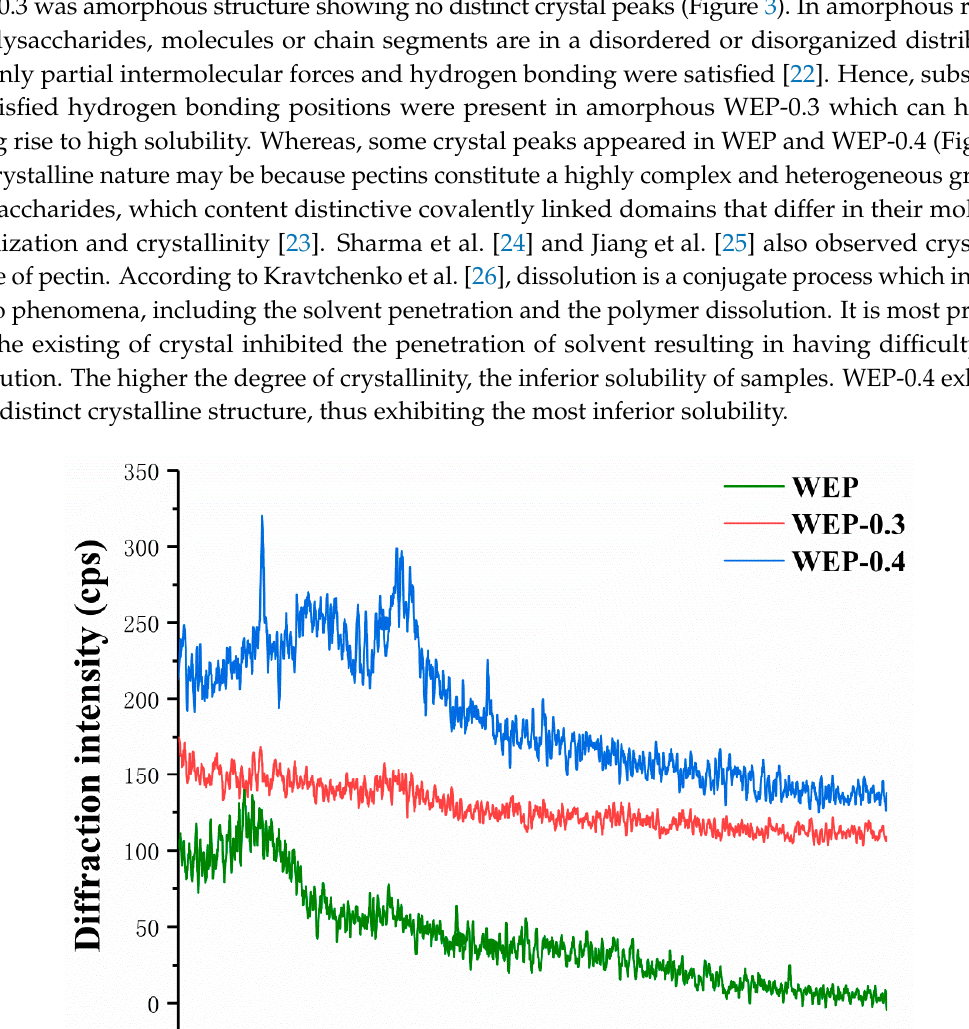
Table 1. Comparison of physicochemical properties of WEP and its fractions (WEP-0.3 and WEP-0.4).